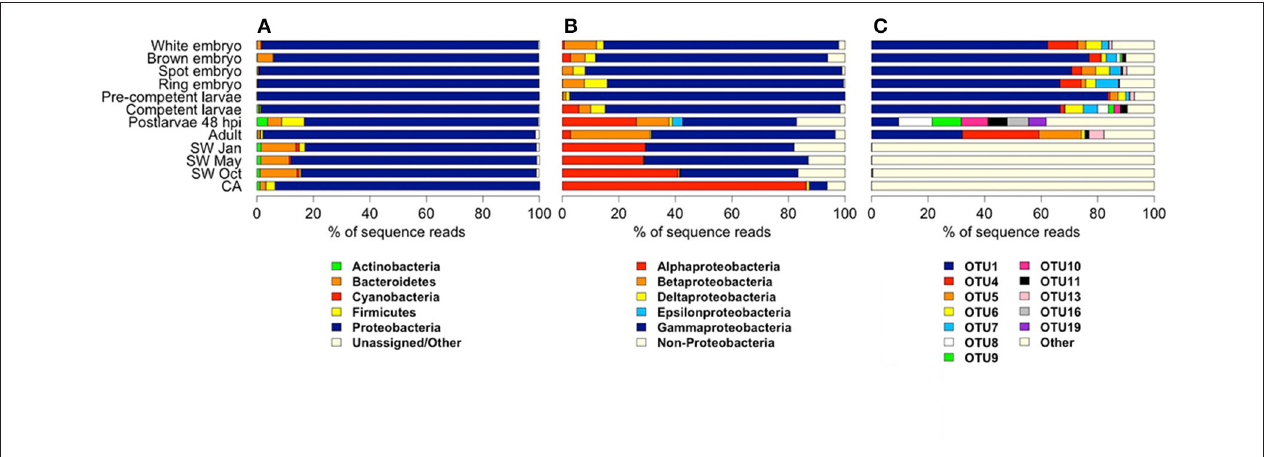
FIGURE 2 | Relative abundance of bacterial and archaeal 16S rRNA gene amplicon reads derived from samples representing different stages in the life cycle of the sponge Amphimedon queenslandica , seasonal seawater (SW) from the sponge native habitat at Shark Bay, and the coralline algae (CA) settlement substrate Mesophyllum sp . Abundances are shown at (A) phylum level, (B) class level within Proteobacteria, and (C) OTU level. In (A) and (B) , common taxa (displaying ≥ 1% read abundance in at least one sample) are coloured. For the CA sample, OTUs matching cyanobacteria-like chloroplast DNA were removed before deriving relative abundance estimates. In (C) , bacterial OTUs shown are those that displayed a relative abundance ≥ 5% in at least one sponge life cycle